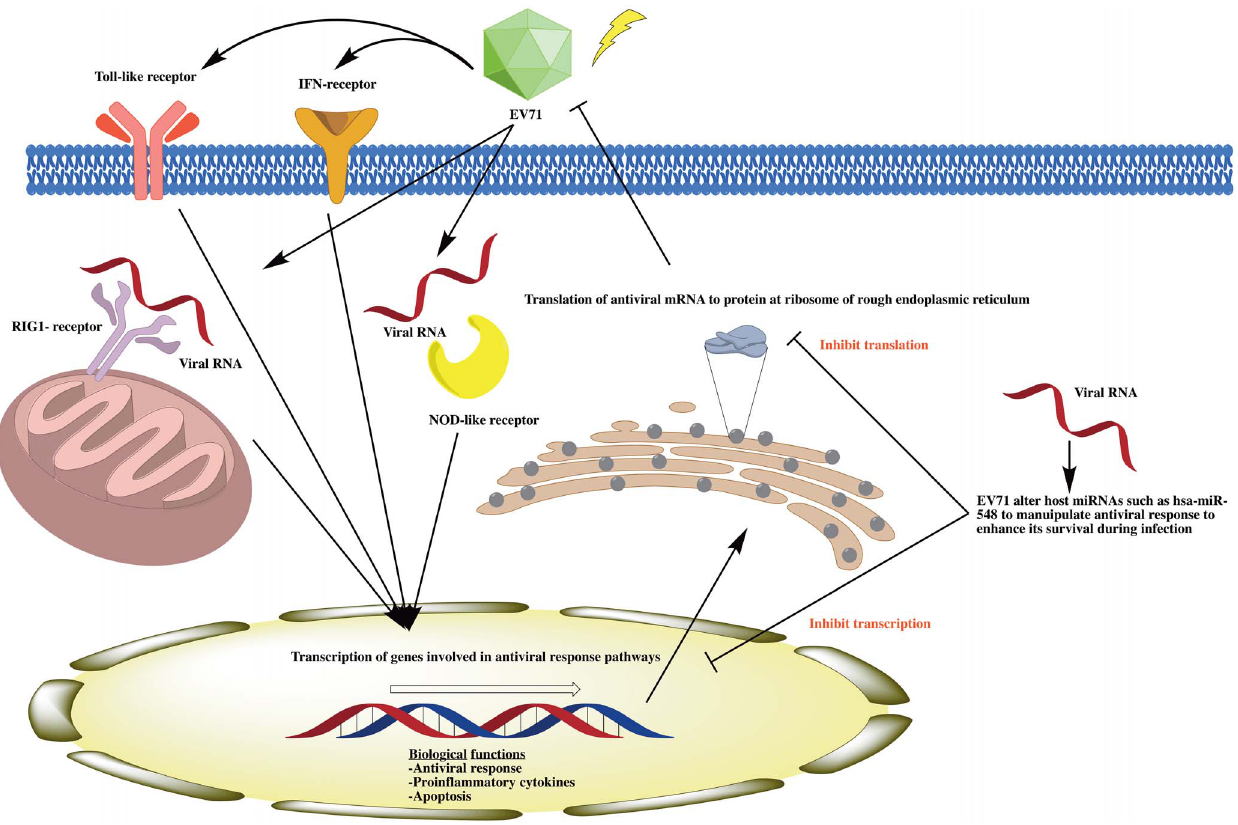
Figure 8. Schematic illustration of the interplay between EV71 and host miRNAs. EV71 altered host miRNAs such as has-miR-548 to manipulate host antiviral responses such as Toll-like signalling, NOD-like signalling, RIG-1 signalling and Type I interferon pathways to enhance its survival during pathogenesis.